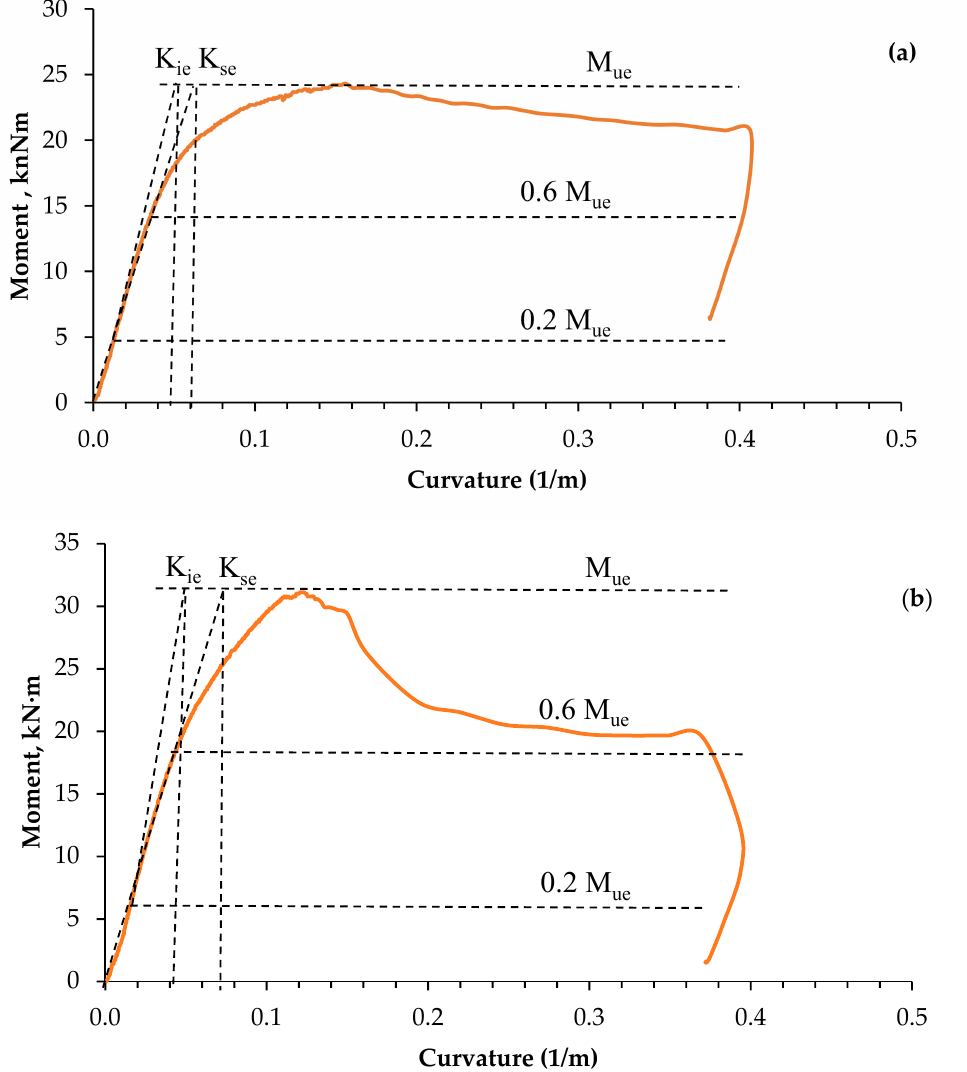
Figure 12. Typical relationships of bending moment–curvature: ( a ) reference specimen (B-C) and ( b ) integrated specimen (B-P100-2L).